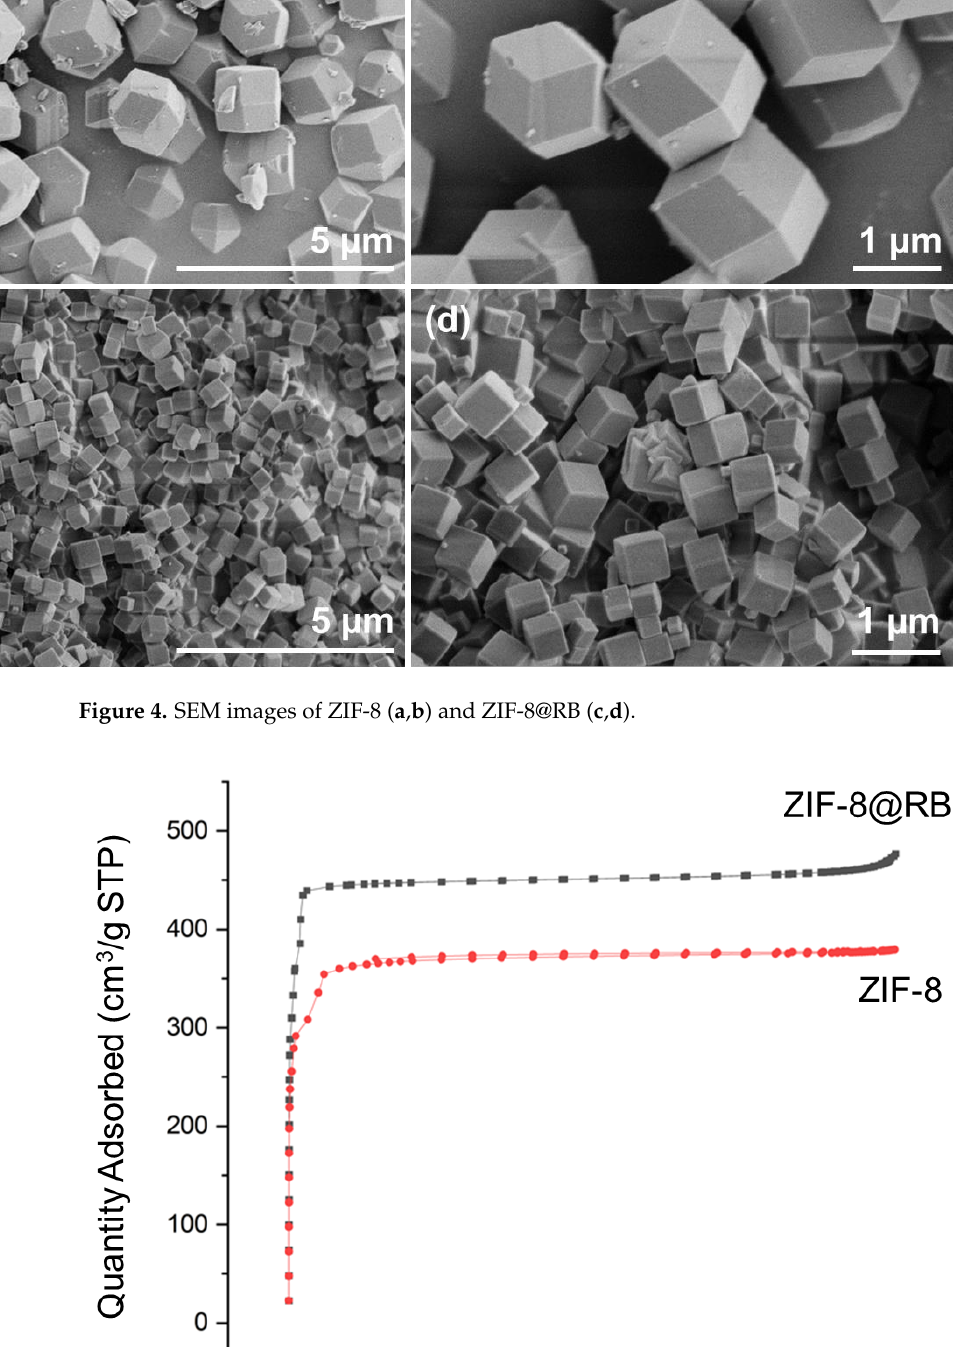
Figure 3. XRD patterns of ZIF-8, ZIF-8@RB and simulated ZIF-8.